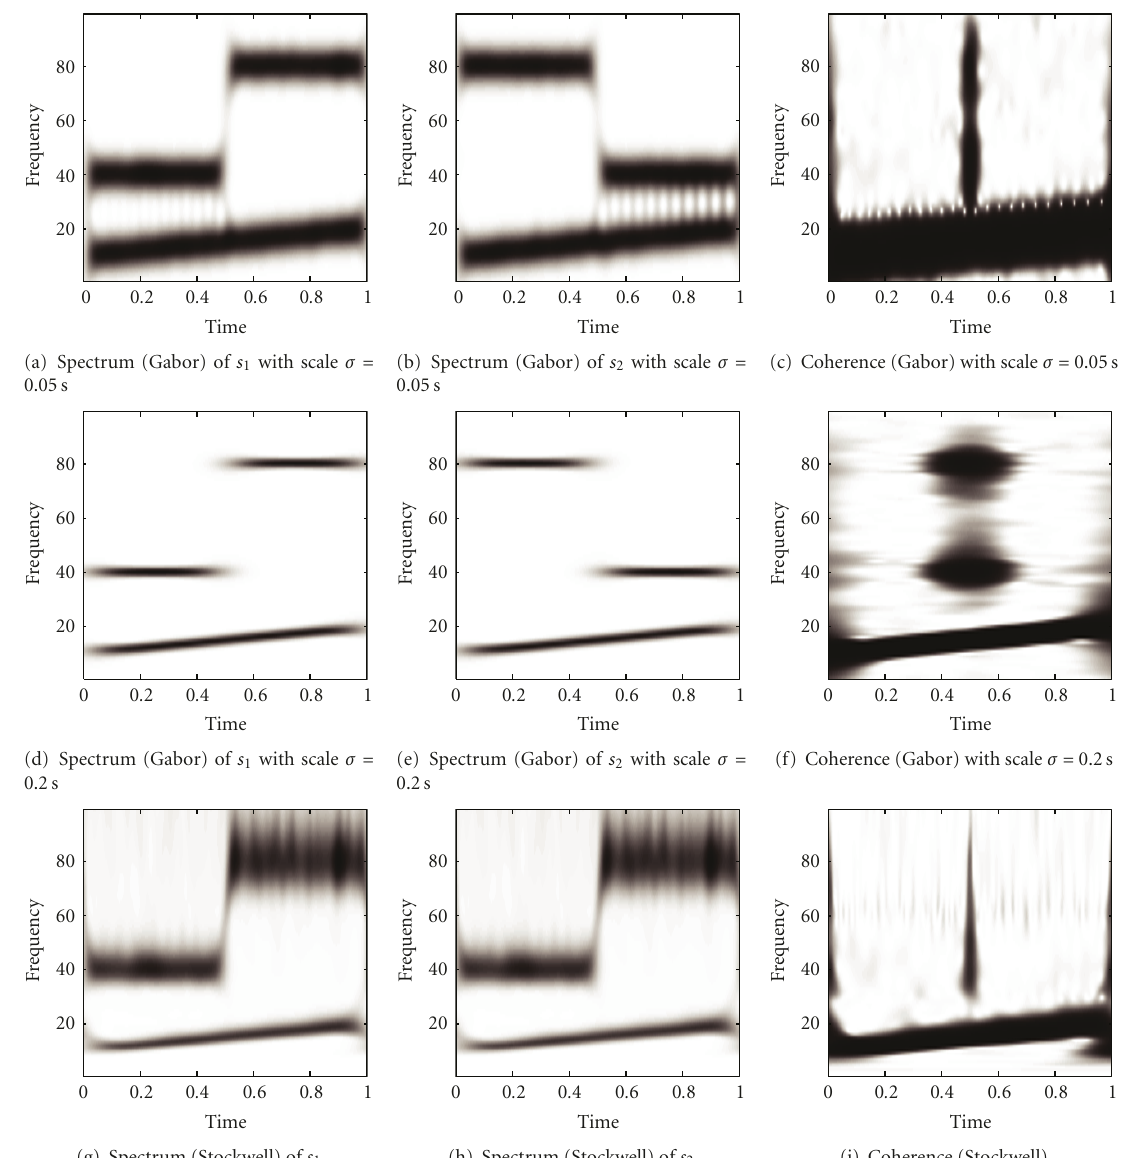
Figure 3: Time-varying spectra of s 1 and s 2 and their coherence obtained from (a)–(c) the GT-spectrogram with the standard derivation of the Gaussian window σ = 0 . 05 s, (d)–(f) the GT-spectrogram with the standard derivation of the Gaussian window σ = 0 . 2 s, and (g)–(i) the